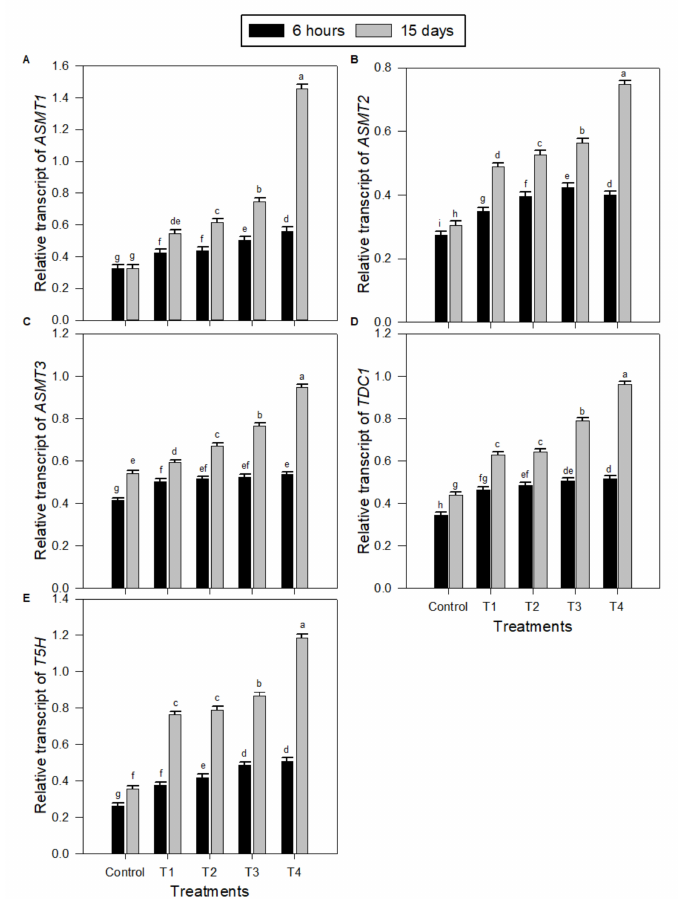
Figure 5. Transcript levels of melatonin biosynthesis encoding genes in peanut seedlings under salinity stress combined with di ff erent exogenous melatonin treatments after 6 h and 15 days. ( A ) ASMT1 , ( B ) ASMT2 , ( C ) ASMT3 , ( D ) TDC , and ( E ) T5H . Transcript levels were quantified by qPCR and normalized against actin and GAPDH transcript levels. qPCR experiments were repeated three times with two technical replicates each. The bars labelled with di ff erent letters are significantly di ff erent. The significant di ff erence marked by di ff erent letters was calculated using the Student’s t -test and further analyzed with the Fisher LSD test, at p ≤ 0.05. The legend is as follows: Control: 0 NaCl + 0 MT, T1: 150 mM NaCl + 0 MT, T2: 150 mM NaCl + 50 µ M MT, T3: 150 mM NaCl + 100 µ M MT, T4: 150 mM NaCl + 150 µ M